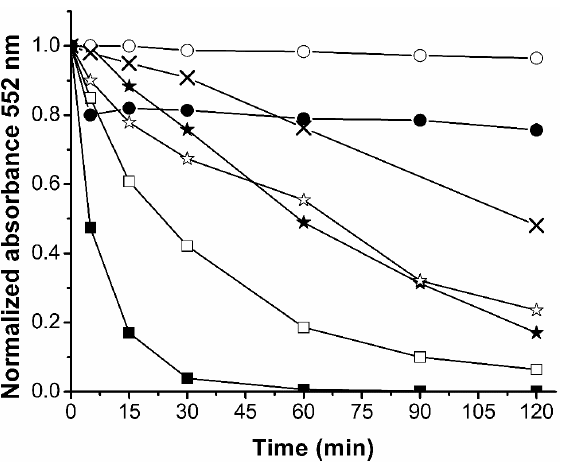
Figure 3. Dye decolorization (rhodamine ‐ B (RB), 5 mg/L) by Magnox/Ultraviolet light (UVC) within different tested operational conditions: dark controls (adsorption) with fixed air flow of 30 L/min, for 0.5 ( ○ ) and 5 g/L ( ● ) of photocatalyst; air fl ow variation with fi xed 0.5 g/L of photocata ‐ lyst, 1.5 ( ☆ ) and 30 L/min ( ★ ); air flow variation with fixed 5 g/L of photocatalyst, 1.5 ( □ ) and 30 L/min ( ■ ); UVC alone (×) with 30 L/min air flow.